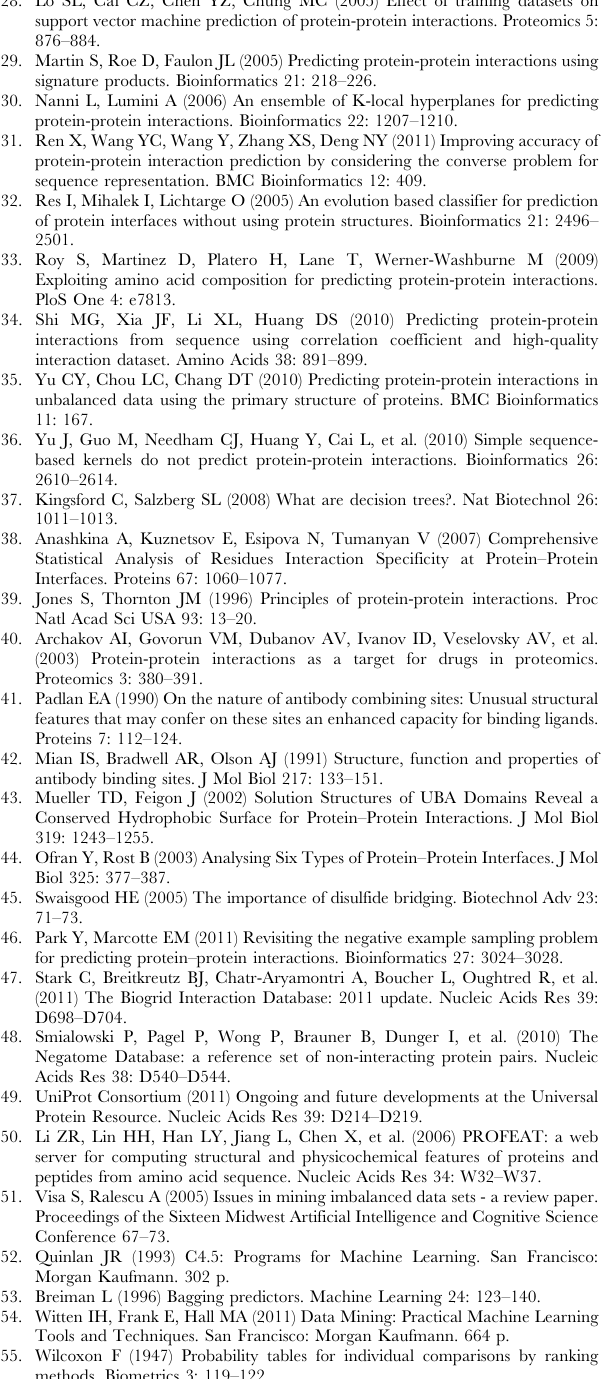
Table S7 Description of the instances presented in the training and test datasets. Include their UniProt accession numbers and species